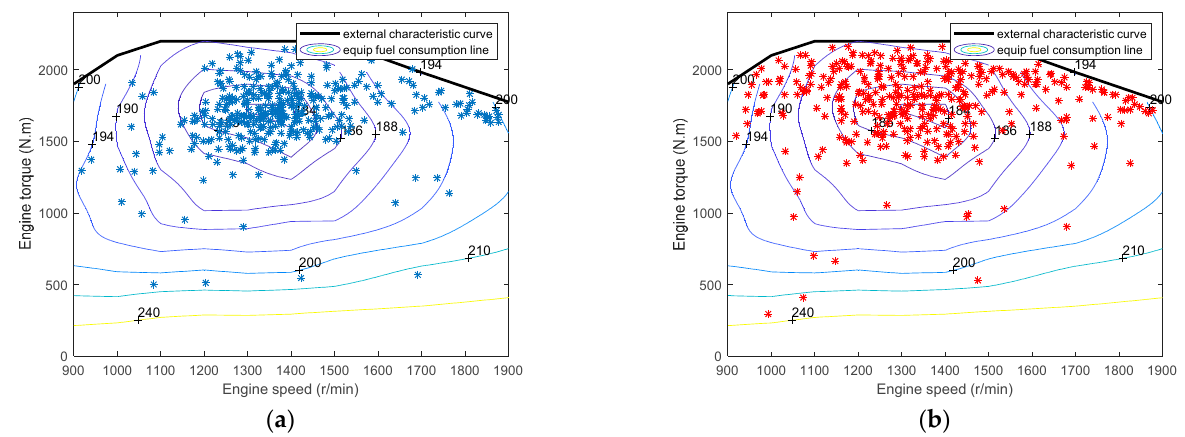
Figure 10. Comparison of engine operating point. ( a ) The dynamic programming and ( b ) the traditional two parameters shift strategy.